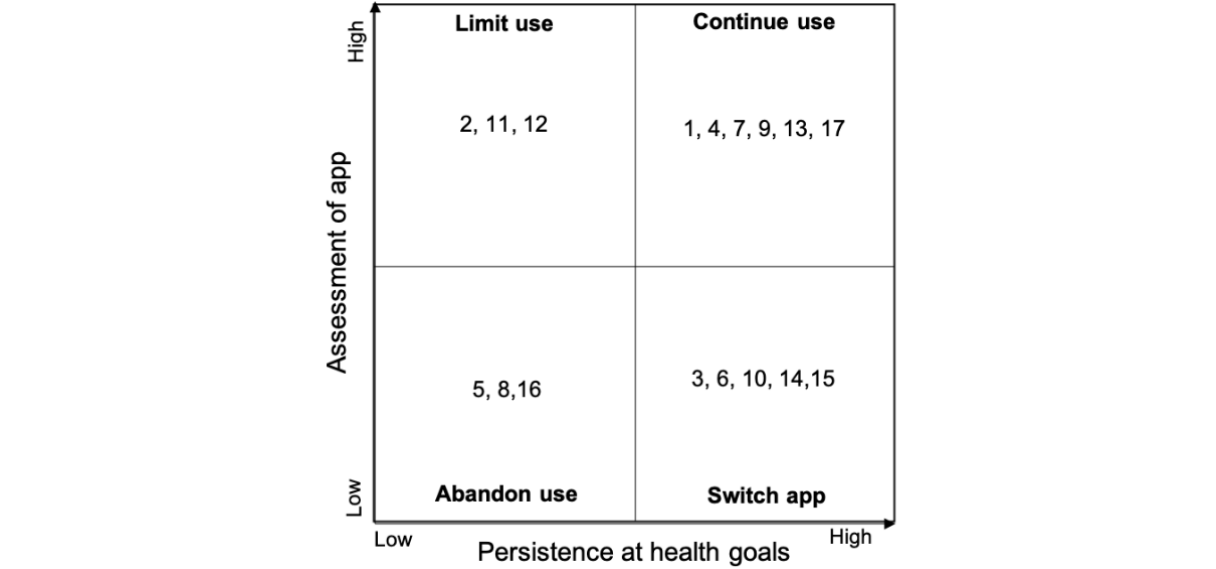
Figure 1. Use decision scenarios regarding mobile health app